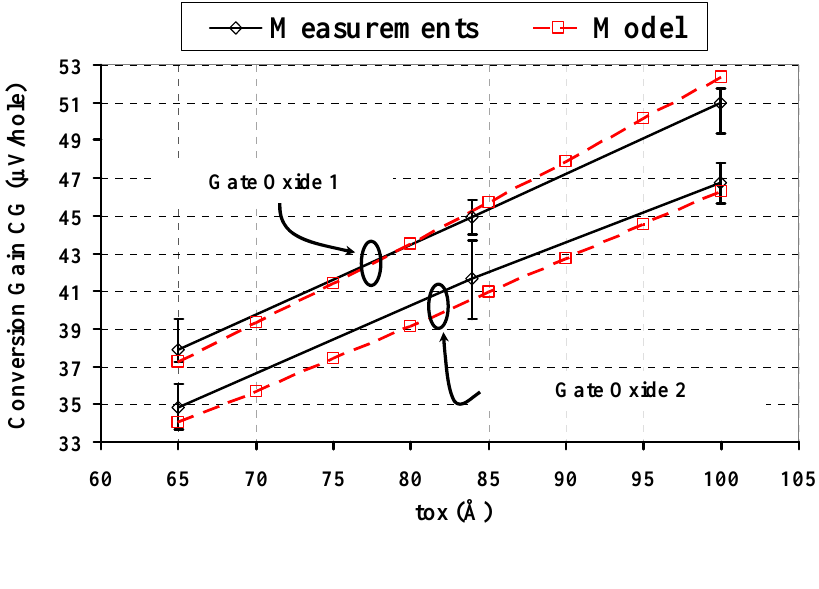
Figure 7. Conversion gain versus gate oxide thickness for two configurations of oxidation process: oxidation with nitridation (gate oxide 1) and oxidation only (gate oxide